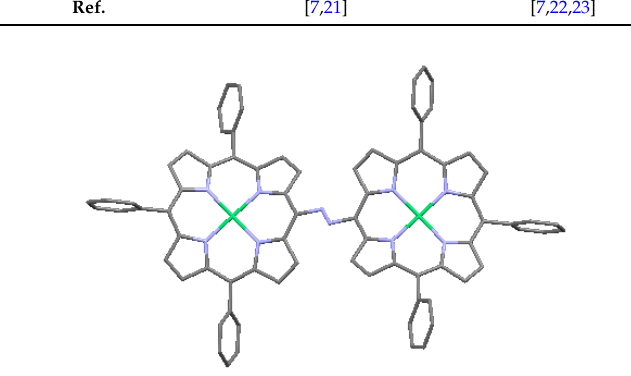
Figure 9. –N=N– covalent meso - meso linkage in TPP-based dimer, from data of [7,21]. Green = Ni.